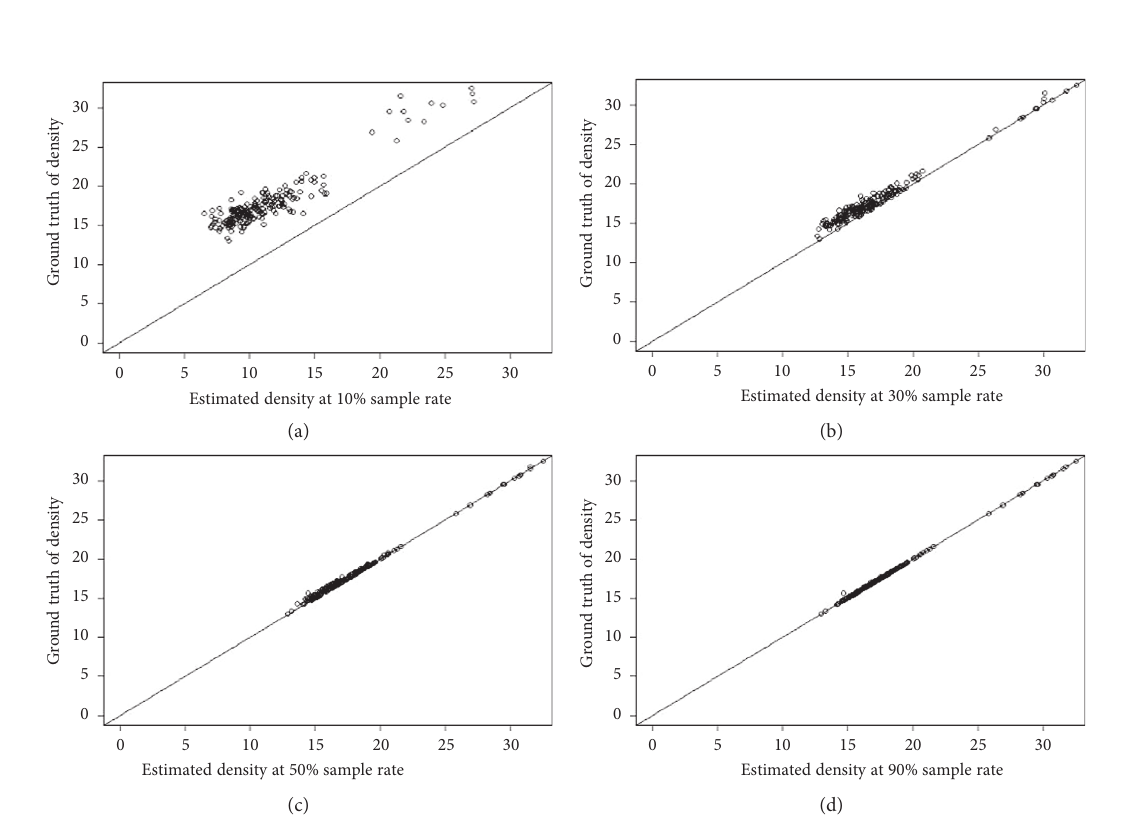
Figure 10: Scatter plot by sample rate of scenario 1 (empirical evaluation). (a) Scatter plot at 10% sample rate. (b) Scatter plot at 30% sample rate. (c) Scatter plot at 50% sample rate. (d) Scatter plot at 90% sample